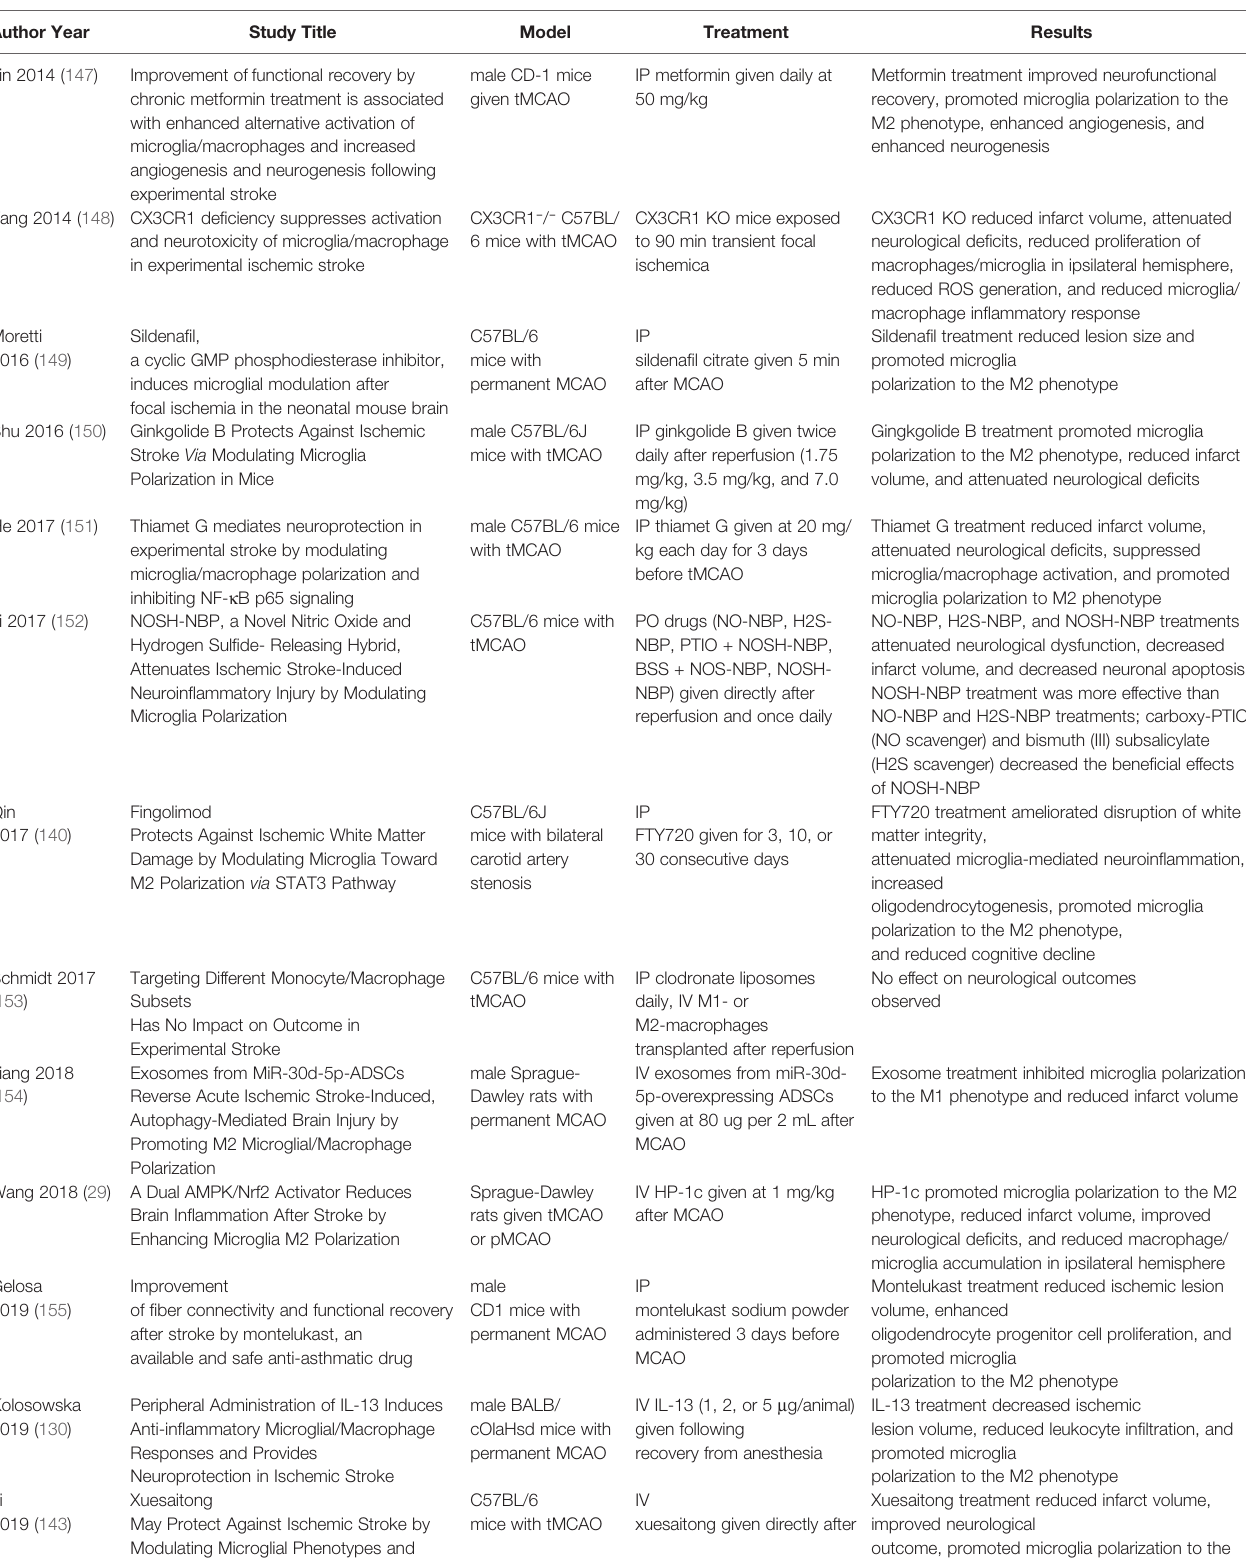
TABLE 1 | Pre-clinical Studies Investigating Microglia, Monocyte, and MoDM Phenotype